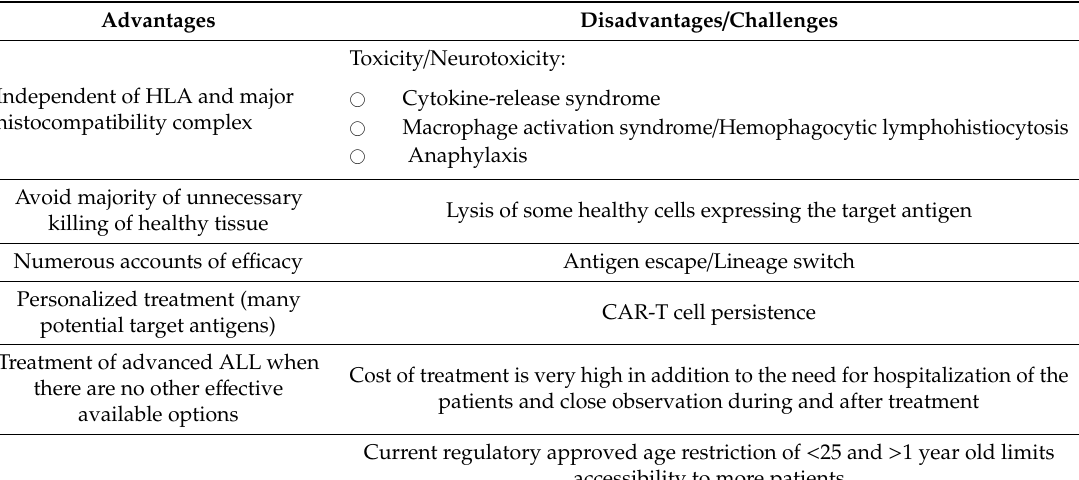
Table 1. Advantages and disadvantages of the application of CAR-T cell therapy in the treatment of B-cell acute lymphoblastic leukemia